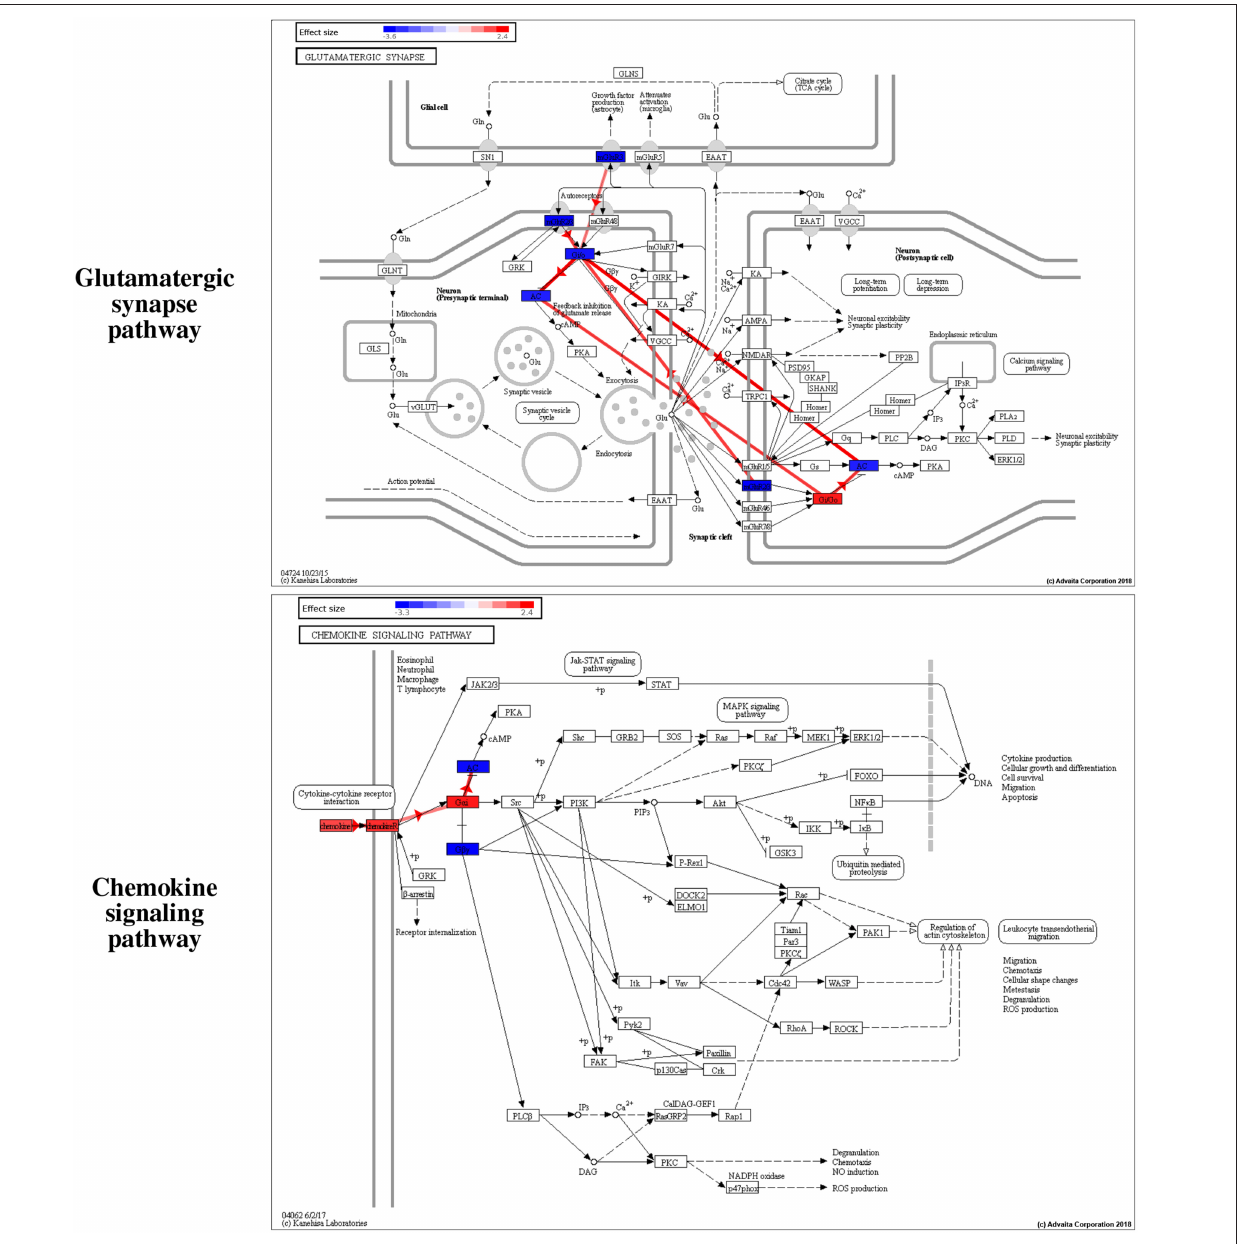
FIGURE 7 | Interesting putative mechanisms are identified by iPathwayGuide (www.advaitabio.com) on the Glutamatergic synapse and the Chemokine signaling pathways. The colors of the nodes represent the effect sizes obtained from the meta-analysis step described in Figure 1A of the manuscript: red represents genes with a positive effect size while blue represents genes with a negative effect size. The edges highlighted in red represent the coherent edges between the genes, which indicate the edges for which the measured effect changes are consistent with the phenomena described by the pathway.